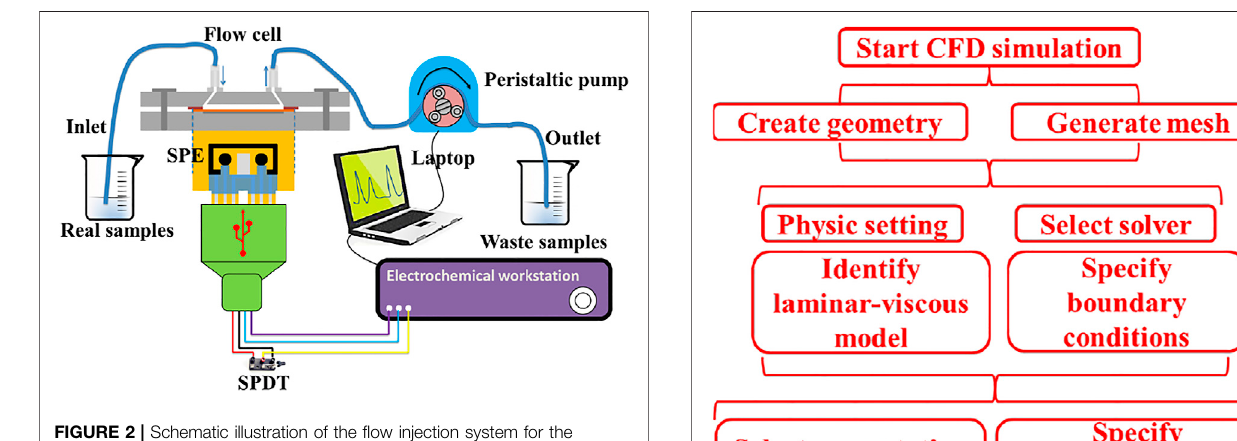
FIGURE 2 | Schematic illustration of the fl ow injection system for the analysis of HMIs.